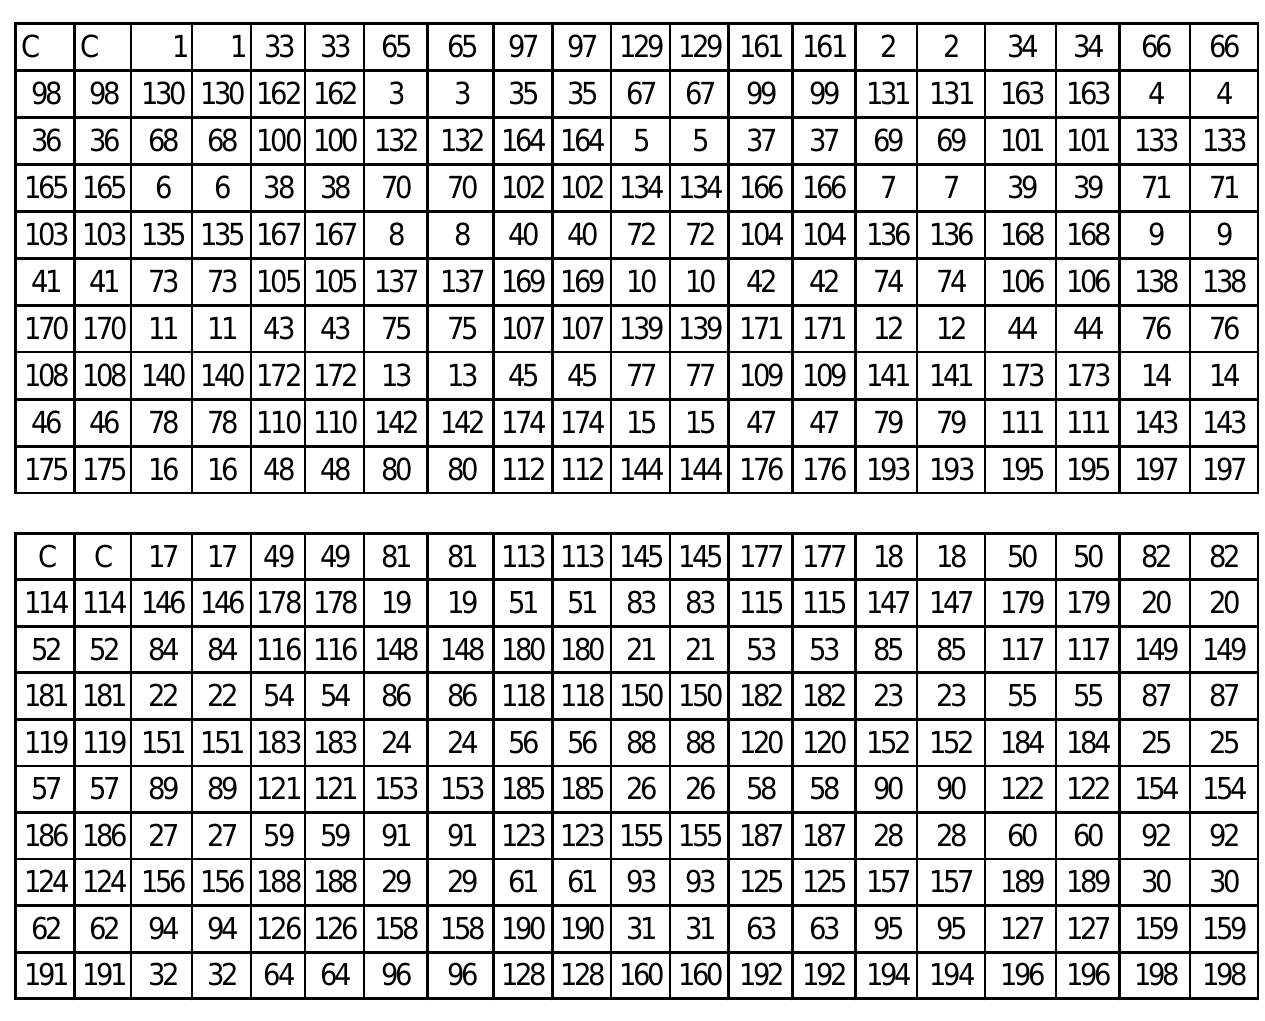
Figure 1: Configuration of the printed microarray spots and the physical location of the corresponding oligonucleotide probes as referenced in Table 1. Control oligonucleotide designated by